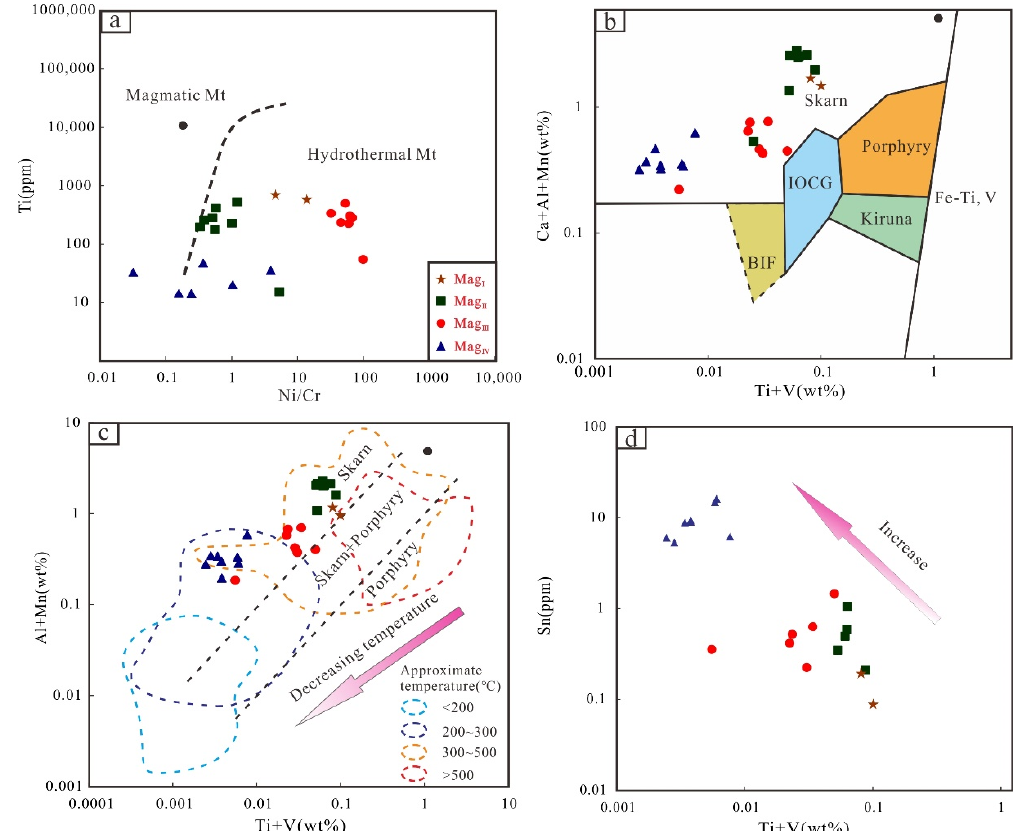
Figure 9. ( a ) Ti vs. Ni/Cr ratio in magnetite, where the boundary is defined by Dare et al. [1]. ( b ) (Ca + Al + Mn) vs. (Ti + V) discrimination diagram for magnetite from the Tonggou deposit, where the fields for Kiruna, IOCG, PCD, skarn, Fe-Ti-V, and BIF deposits were defined by Dupuis and Beaudoin [7]. ( c ) (Al + Mn) vs. (Ti + V) diagram for magnetite (modified after [1]) from the Tonggou deposit. ( d ) Sn vs. (Ti + V) diagram for magnetite from the Tonggou deposit.